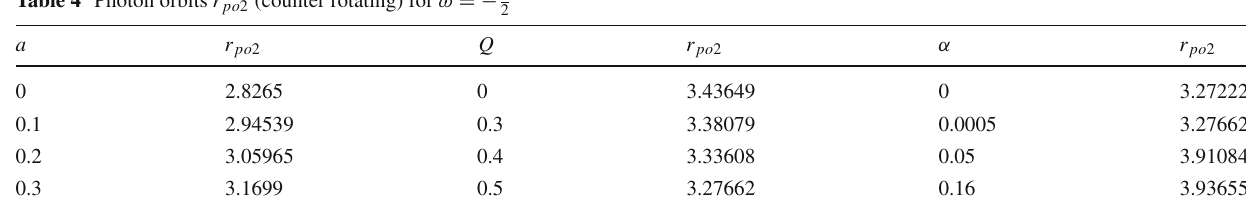
Table 4 Photon orbits r po 2 (counter rotating) for ω = − 1